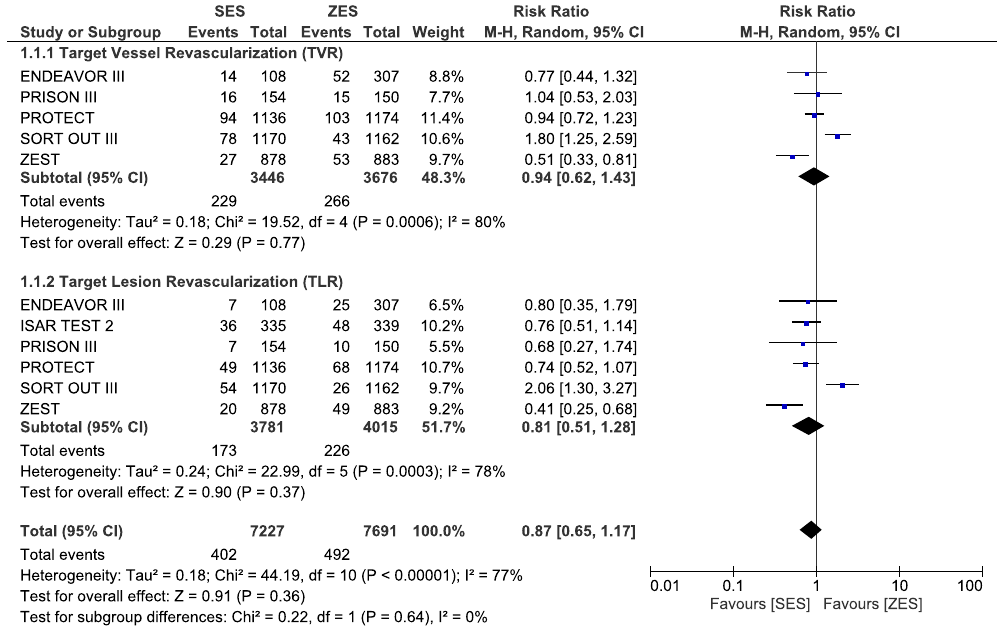
Figure 6. Long-term adverse clinical outcomes which were associated with ZES versus SES alone (part 2).